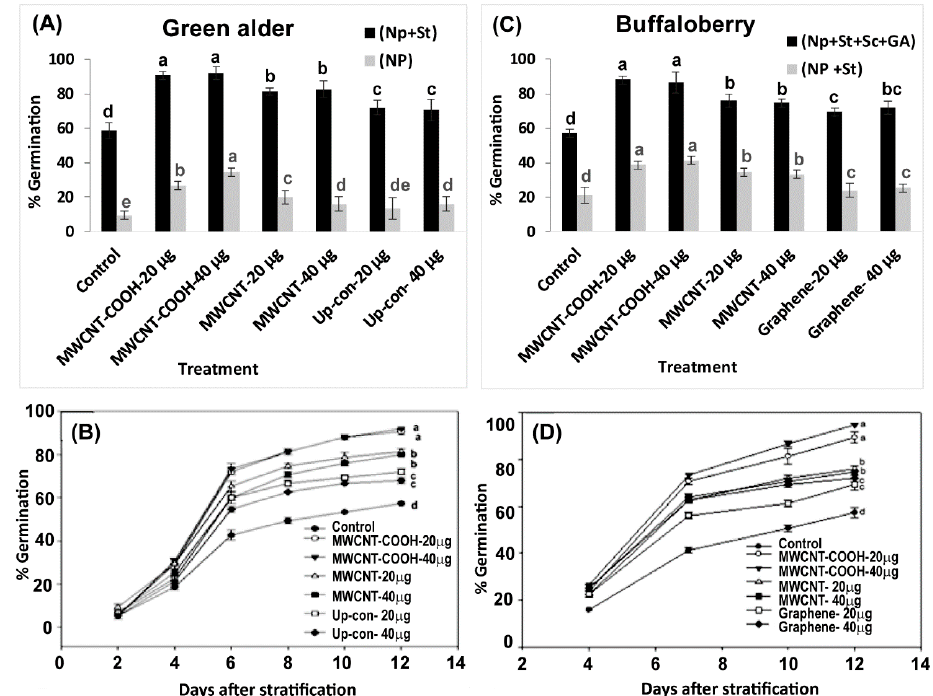
Figure 5. Effects of stratification and nanopriming treatments on seed germination percentage in green alder ( A ), buffaloberry ( B ) as well as temporal variations in germination percentage in green alder ( C ) and buffaloberry ( D ). Vertical bars or line graph represent germination percentage in green alder and buffaloberry ± standard errors. Different letters show significant differences among treatments at α = 0.05. Control = no CNPs added, MWCNT–COOH = multiwall carbon nanotubes functionalized with carboxylic acid, MWCNT = multiwall carbon nanotubes, UP-con NP = up conversion nanophosphors, N = 100 plants per treatment.